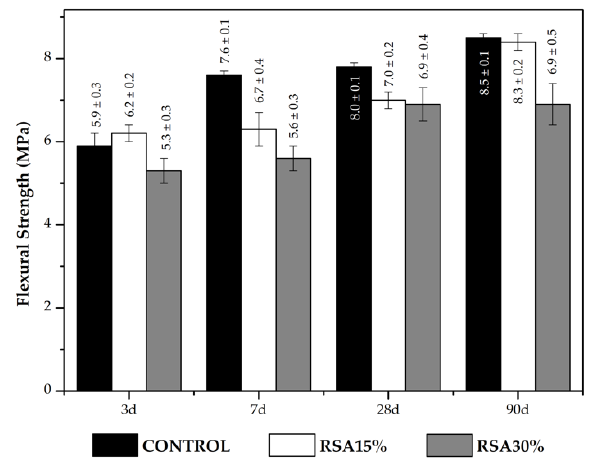
Figure 12. Flexural strength of the analyzed PC/RSA mortars after 3, 7, 28 and 90 days.